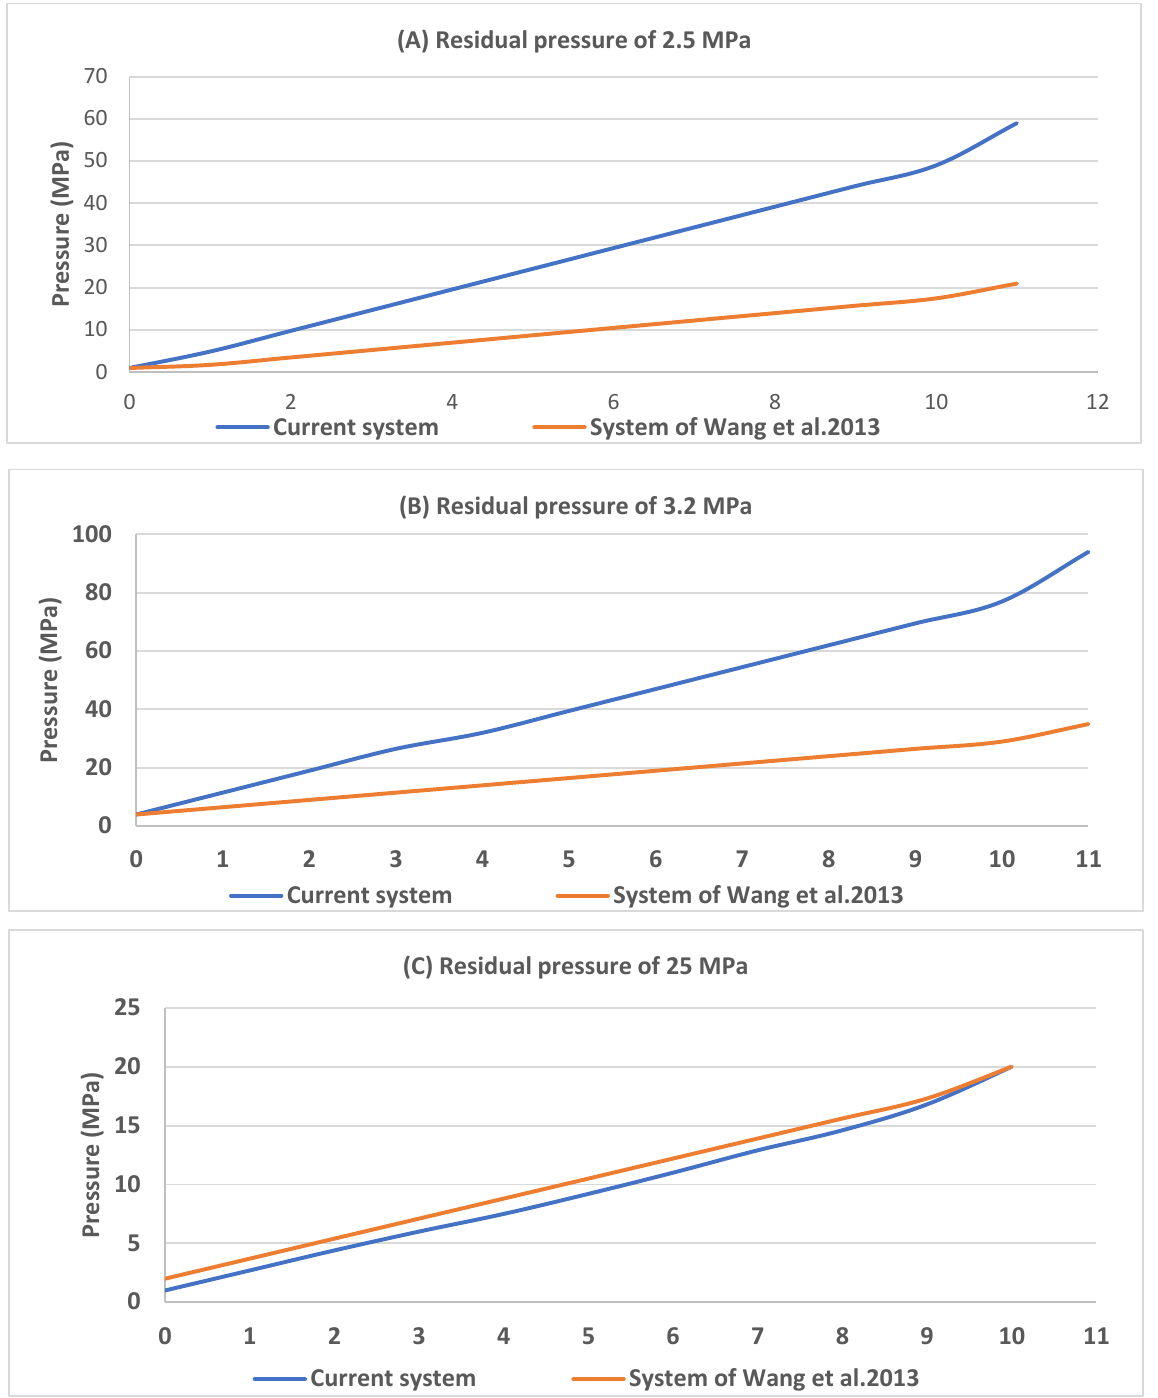
Figure 5. Changes in output energy density for a residual pressure of: ( A ) 2.5 MPa; ( B ) 3.2 MPa and; ( C ) 25MPa compared to 𝜖 under pressure conditions.